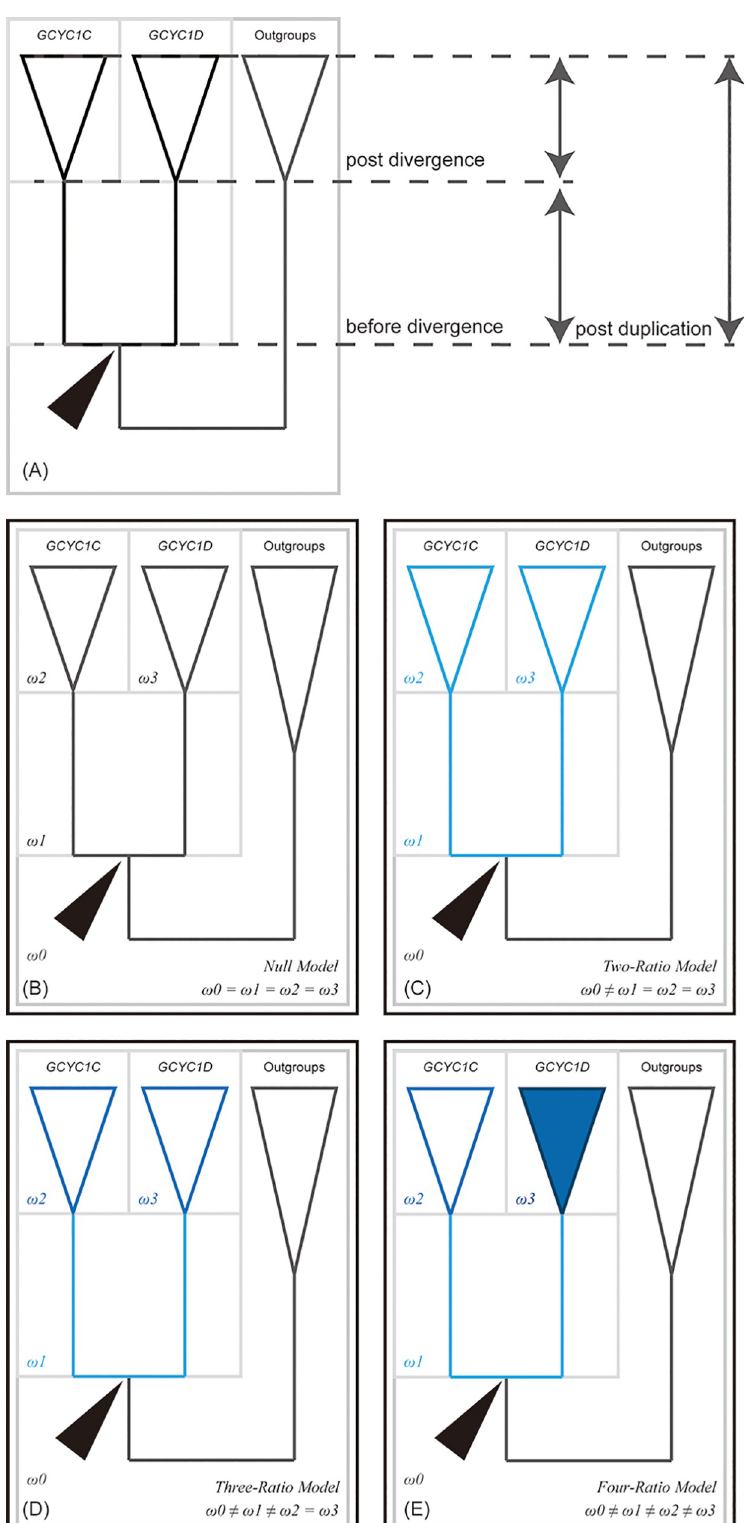
Fig 2. Branch models used in PAML analyses. (A) Schematic representation of the tree used in PAML. Arrowheads indicate the duplication event. Post duplication denotes all branches arising after the duplication event. Before